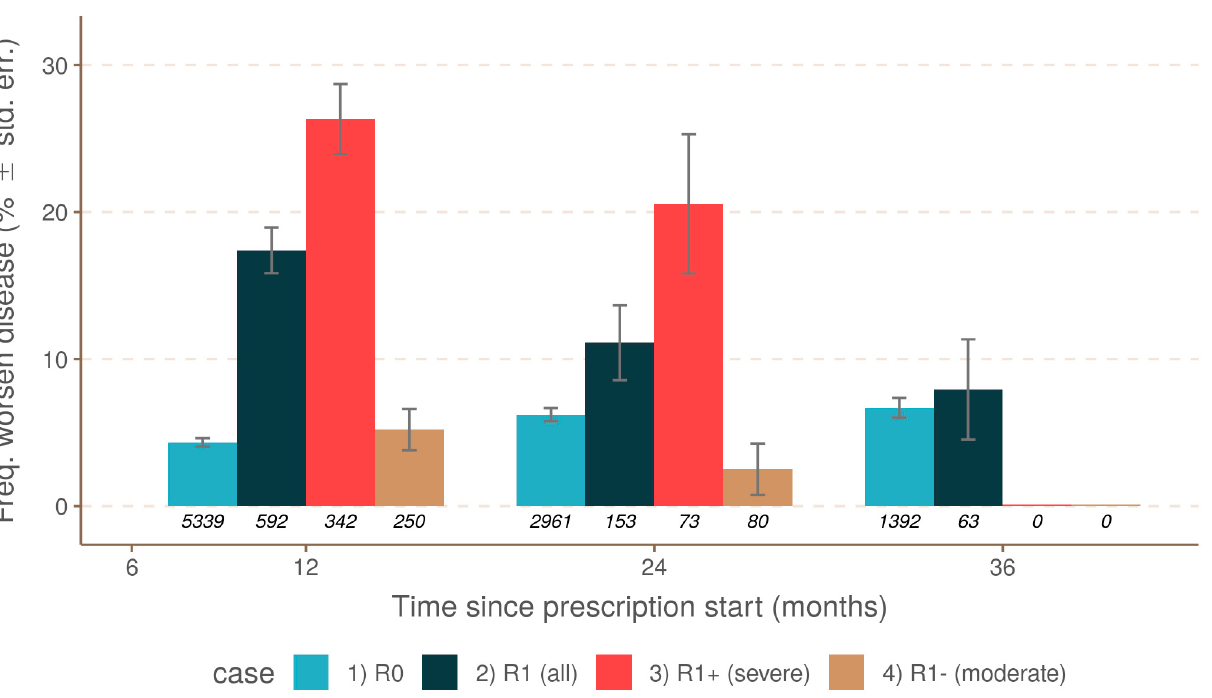
Figure 2. Comparison of disease worsening and one relapse during the first year of treatment (between 6 and 12 months). Colors are for: R0 = no relapse, R1 = relapse during the first year.